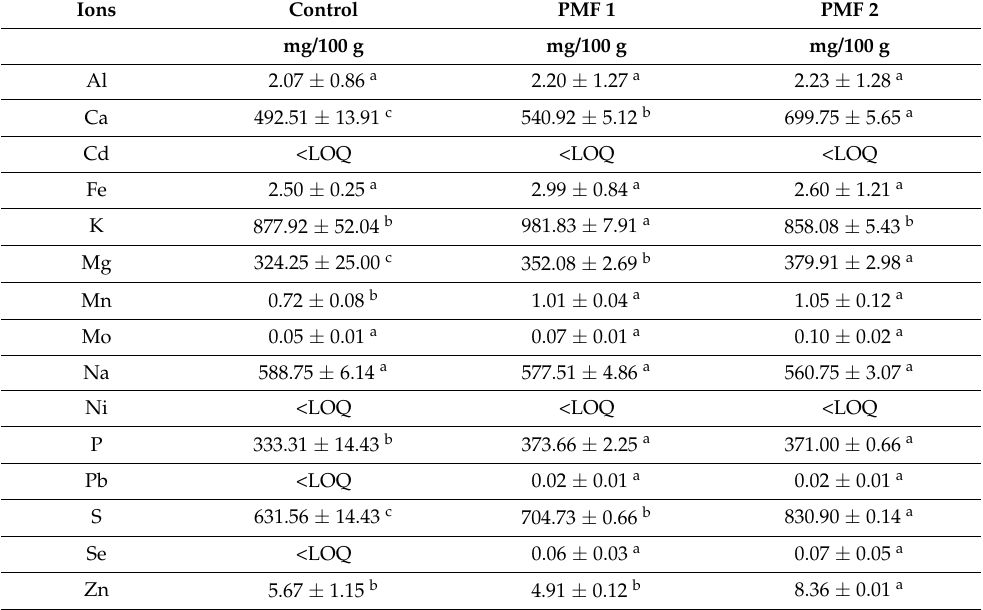
Table 2. Changes in the content of basic micro and macro components and heavy metals under the influence of applied pulsed magnetic fields for cress